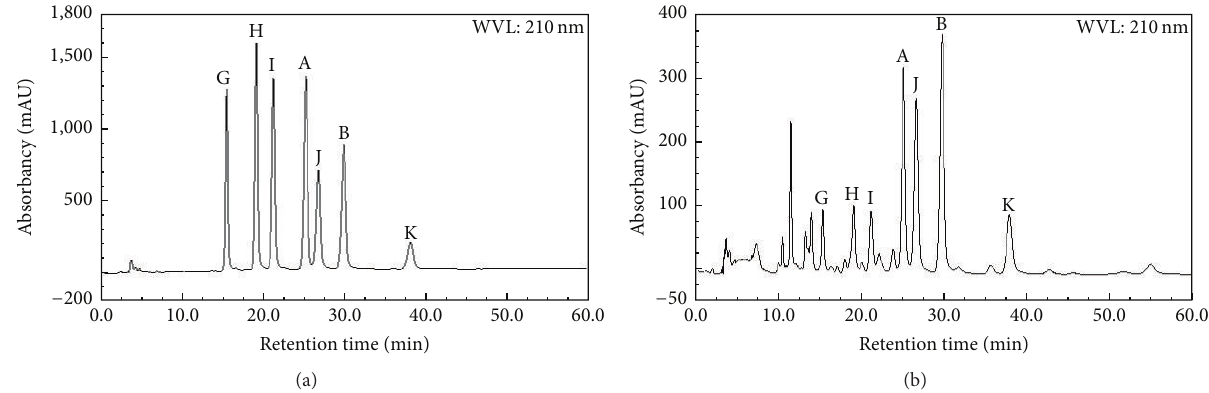
Figure 2: The HPLC chromatograms of gentisides A, B, G, H, I, J, and K; (a) the chromatogram of standard substance; (b) the chromatogram of sample.